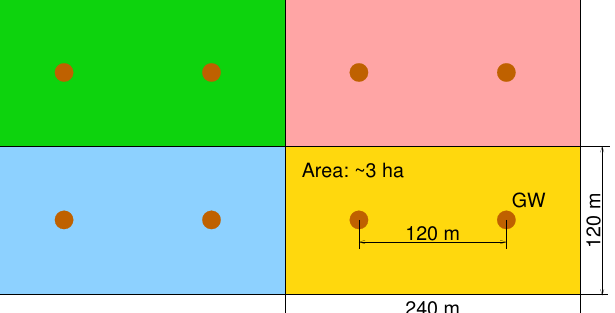
Figure 5. The network is made of independent cells with a star topology inside (the distances assume a 200 m sensor communication range). The sensors in each cell are covered by two gateways, which can independently contact the server to ensure redundant field message aggregation and upload. Larger areas can be covered by joining elementary cells.